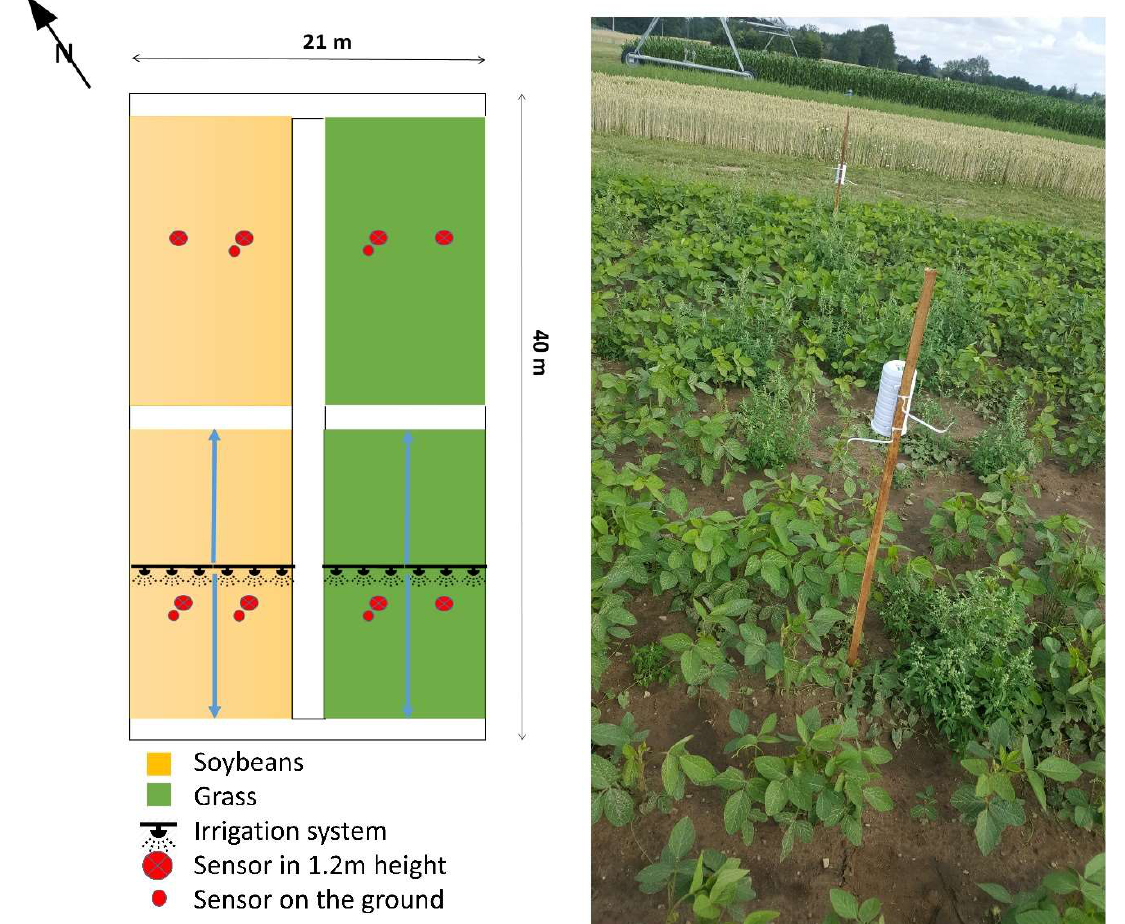
Figure 2. The location of each sensor in the field (left). All sensors located at a height of 1.2 m.